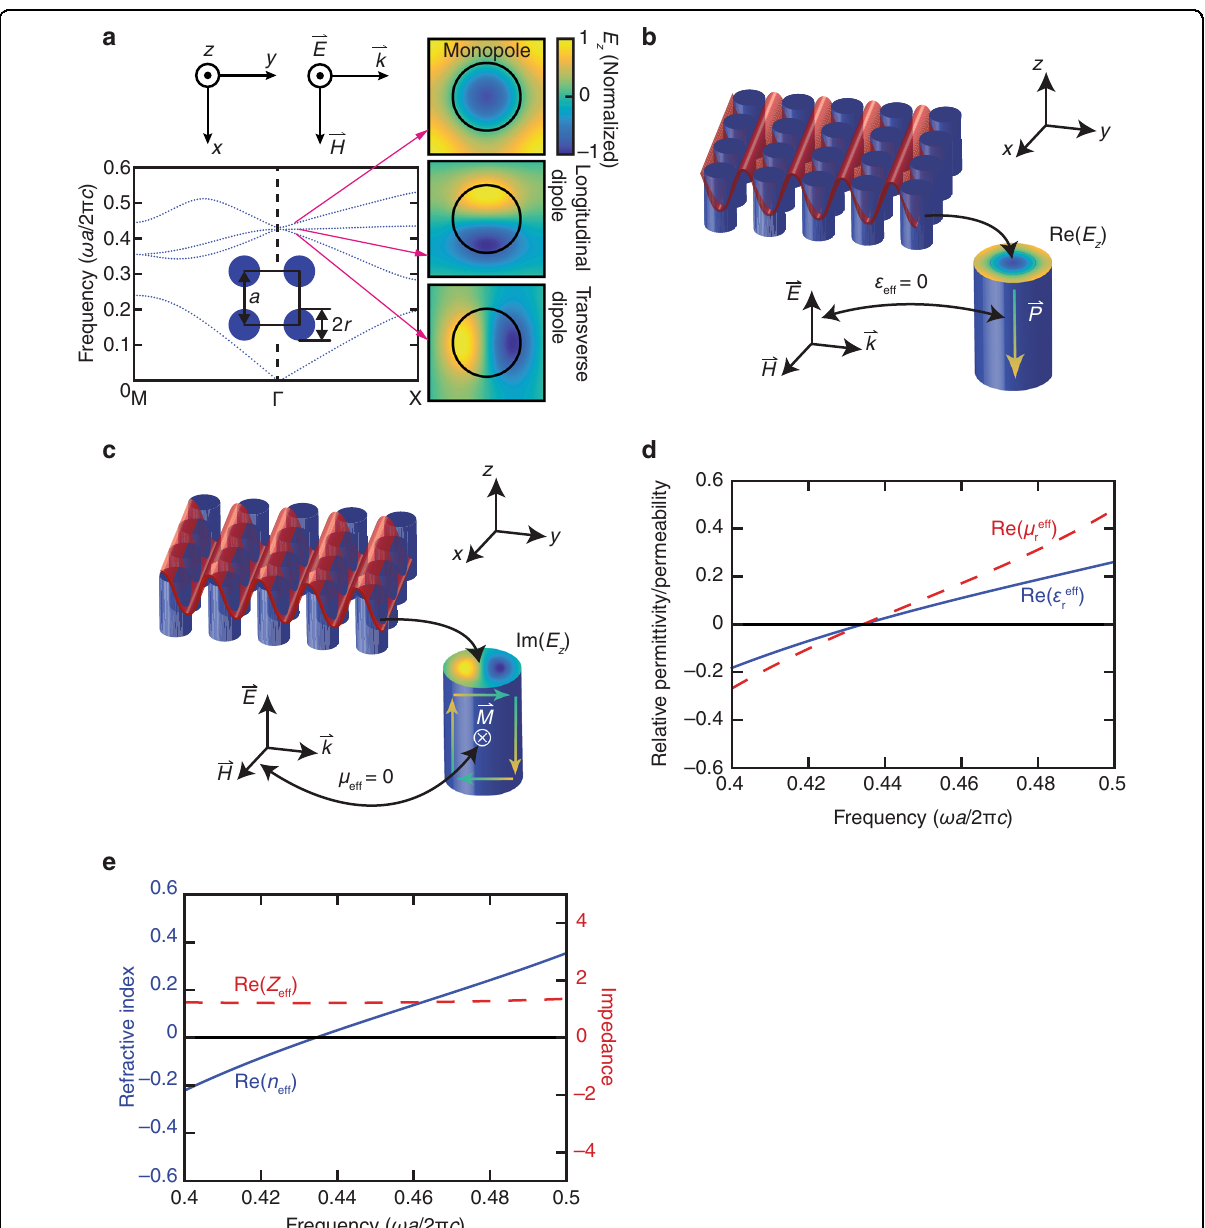
Fig. 1 A Dirac-like cone dispersion induces an impedance-matched zero index. a Photonic bandstructure of a square lattice of 2D dielectric pillars (inset) and the three modes (right) forming the TM Dirac-like cone dispersion. b An electrical monopole mode induces an effective permittivity of zero. c A transverse magnetic dipole mode induces an effective permeability of zero. d The effective permittivity and permeability as well as e the effective refractive index and impedance calculated by an effective medium theory